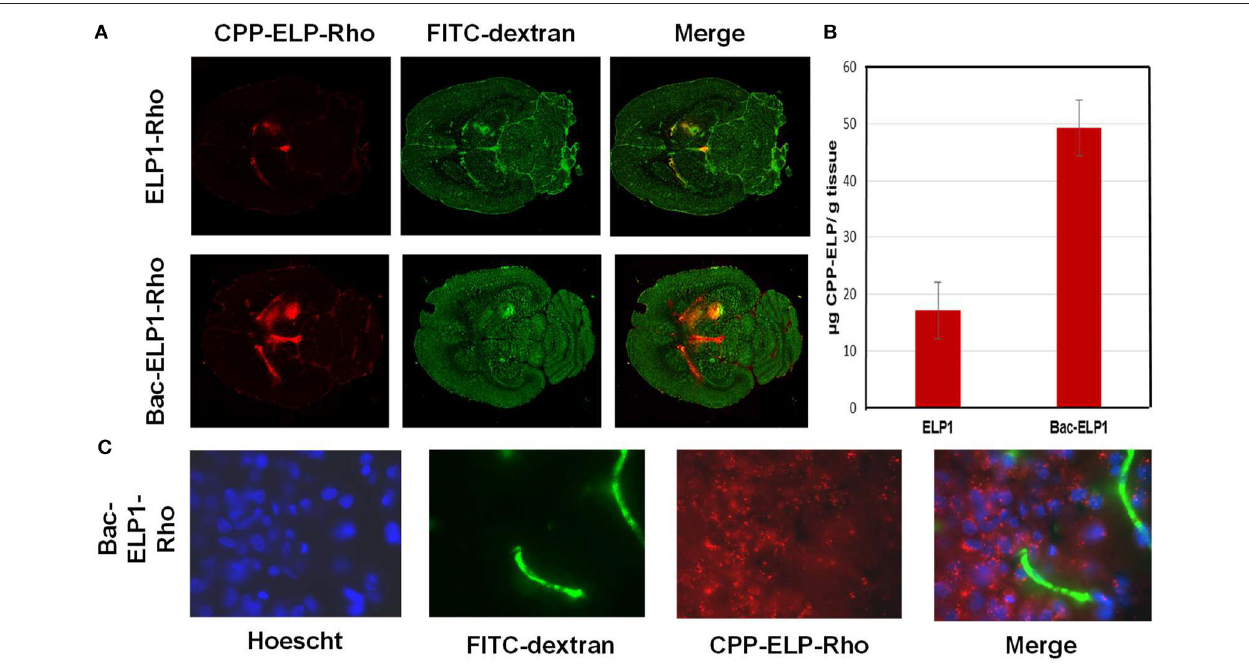
FIGURE 5 | Tumor and Cellular Uptake of CPP-ELP. (A) Distribution of rhodamine-labeled polypeptides in tumor and normal brain relative to perfused vasculature. Rhodamine fluorescence was used to follow the localization of the polypeptide within the tumor (left panel); the perfused vasculature was marked by infusion of high molecular weight dextran 1min prior to euthanasia (middle panel). (B) Tumor levels 4h after IV administration of rhodamine-labeled ELP or CPP-ELPs. Bars, s.e.*, Tumor levels are significantly enhanced ( p , 0.01, one way ANOVA with post-hoc Bonferroni, n = 6 rats/group). (C) Microscopic images of tumor sections were collected after staining cell nuclei with Hoechst 33342 using a 60 X magnification objective.